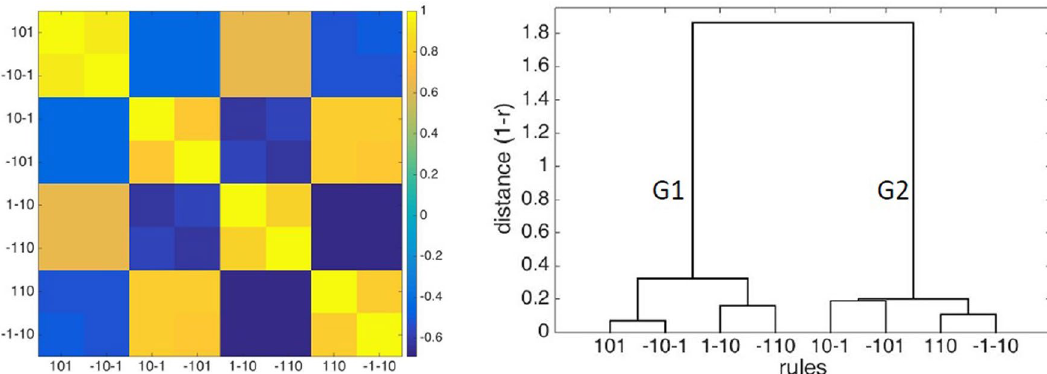
Figure 7. Classification of functional rules. Left panel: correlation matrix among rules (Pearson C.I. scale on the right axis). Right panel: dendrogram produced by a hierarchical cluster analysis. In the hierarchical structure symmetrical rules are clustered: ( a ) In the same group in the first level: (101, − 10–1), (1–10, − 110) (10–1, − 101), (110, − 1–10); ( b ) again in two groups in the second level [(101, − 10–1), (1–10, − 110)]; [(10–1, − 101), (110, − 1–10)]. Rules grouped in the second level appear anti-correlated in the correlation analysis of the left panel). Function G1